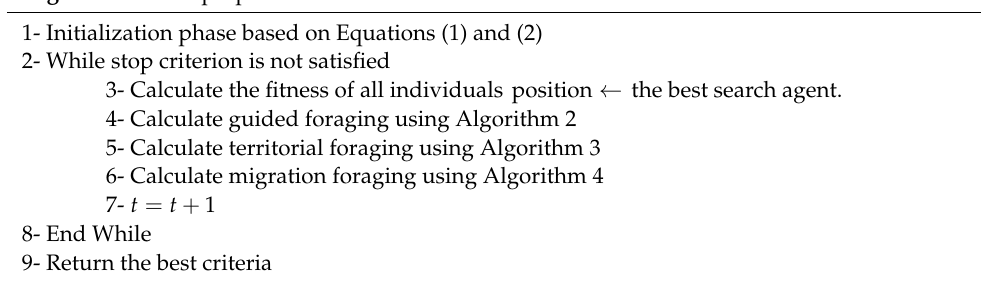
Algorithm 5: The proposed